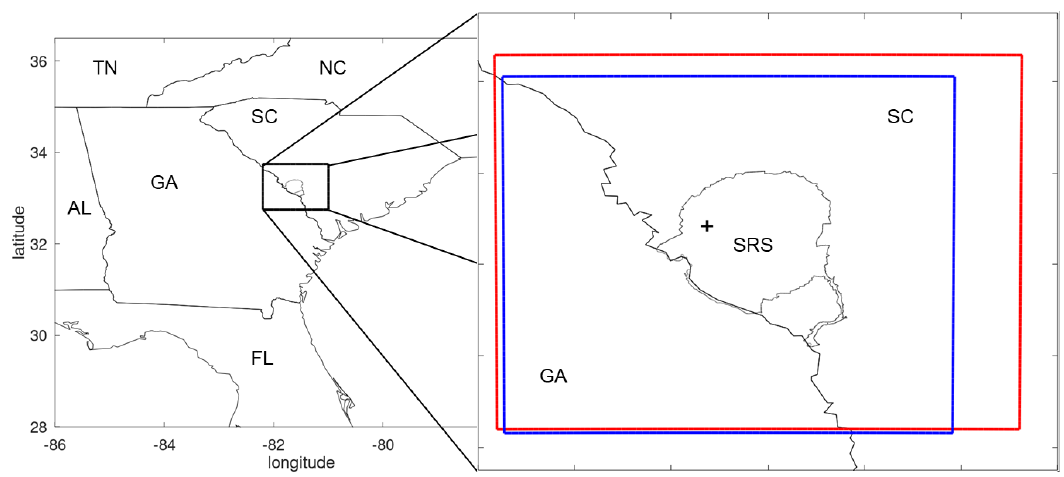
Figure 1. Location and size of forecast area in the southeastern US (state abbreviations as noted). RAMS inner domain, red box; WRF inner domain, blue box; ceilometer located at black cross on the Savannah River Site (SRS).